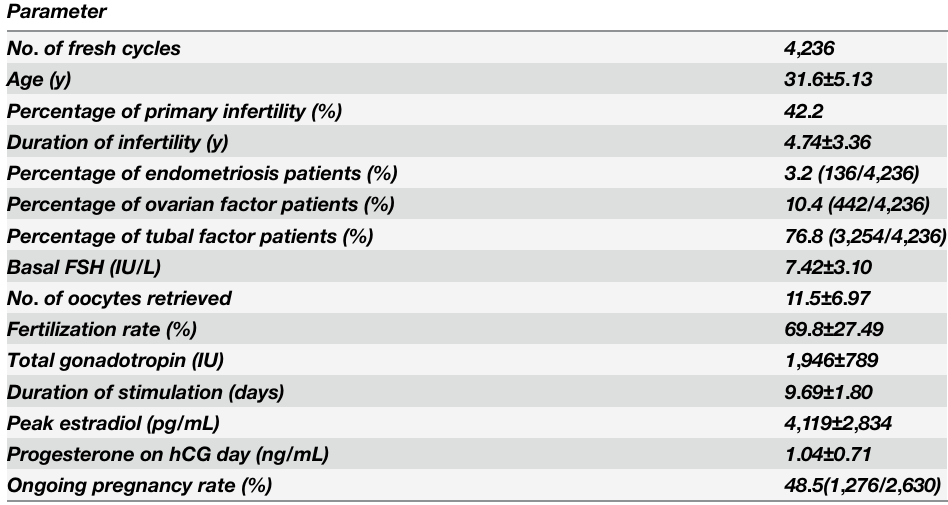
Table 1. Clinical features and cycle outcomes of ovarian stimulation of IVF cycle patients.